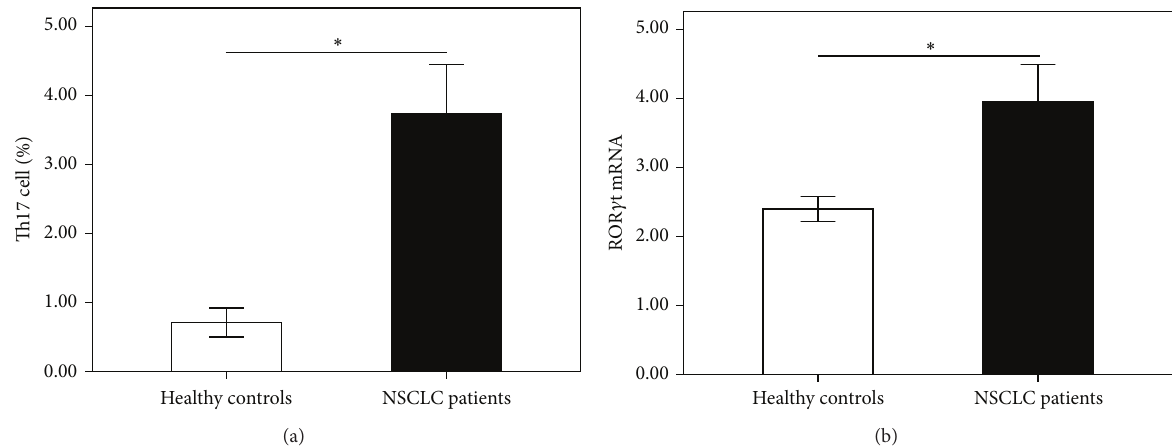
Figure 4: The frequency of CD4+IL-17+ Th17 cells was measured by using flow cytometry, and the mRNA expression of ROR 𝛾 t in peripheral blood was measured by using QPCR. The proportion of Th17 cells (a) was significantly increased in NSCLC patients compared with healthy controls. The mRNA expression of ROR 𝛾 t (b) was significantly higher in NSCLC patients than in healthy controls. Results are expressed as pg/mL (mean ± SD). 𝑛 = 19 ; ∗ 𝑃 < 0.001 .